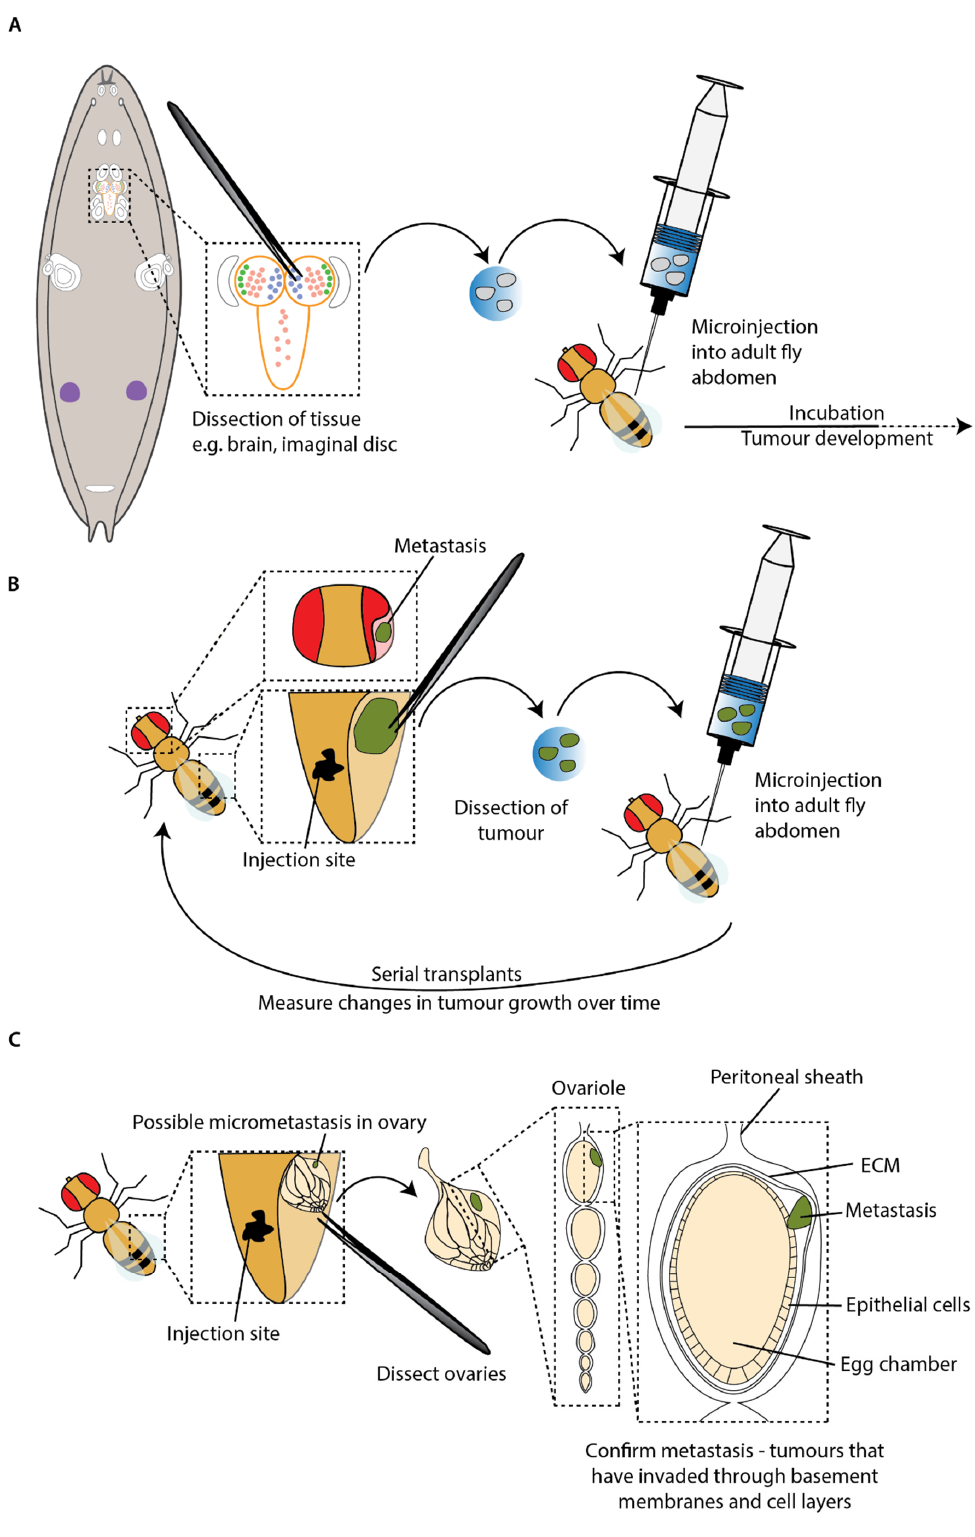
Figure 4. Transplantation experiments to model metastasis. ( A ) Transplantation of larval tissue into adult hosts. Tumours are induced in larvae, usually in the imaginal discs or the brain, and